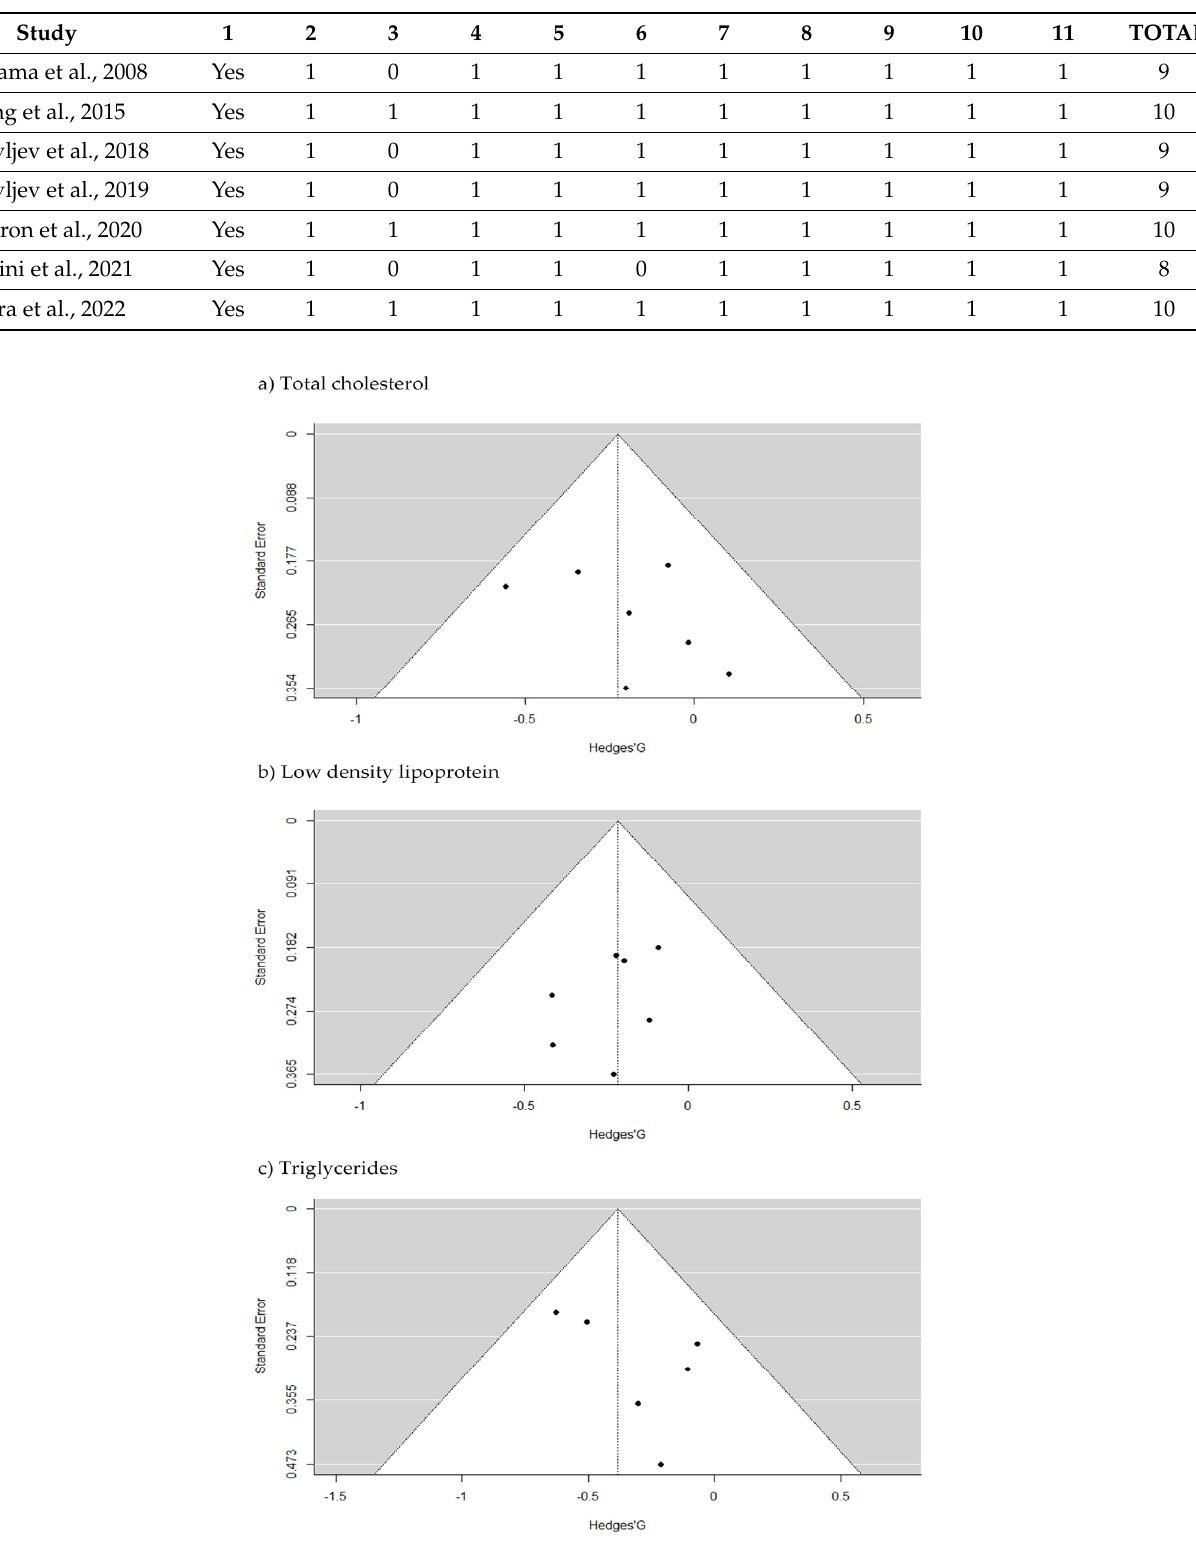
Figure 2. Funnel plots of included studies. Funnel plot (standard error vs. Hedges’ G) for all of the included studies in this SRMA. There were no risks of heterogeneity considering total cholesterol (I 2 = 0%; p = 0.49), low density lipoprotein (I 2 = 0%; p = 0.95) and triglycerides (I 2 = 0%; p = 0.47). For the HDL levels the I 2 square test noticed no significant heterogeneity between studies ( p = 0.12). Nevertheless, the I 2 statistic observed a moderate risk of heterogeneity (I 2 = 20.85%). The visual analysis of the funnel plot indicated asymmetry showing publi- cation bias (Figure 3a). However, no significant results were found in the Egger´s regres- sion test for funnel plot asymmetry (df = 5; p = 0.86), and Duval and Tweedie Trim and Fill´s method did identify one missing studies on left side of the plot. After excluding the studies not evenly distributed around the base of the funnel plot, the heterogeneity be- tween studies was drastically reduced, showing a low risk of heterogeneity (I 2 = 0%; p = 0.84). Egger´s regression test showed no funnel plot asymmetry (df = 5; p = 0.84) and Duval